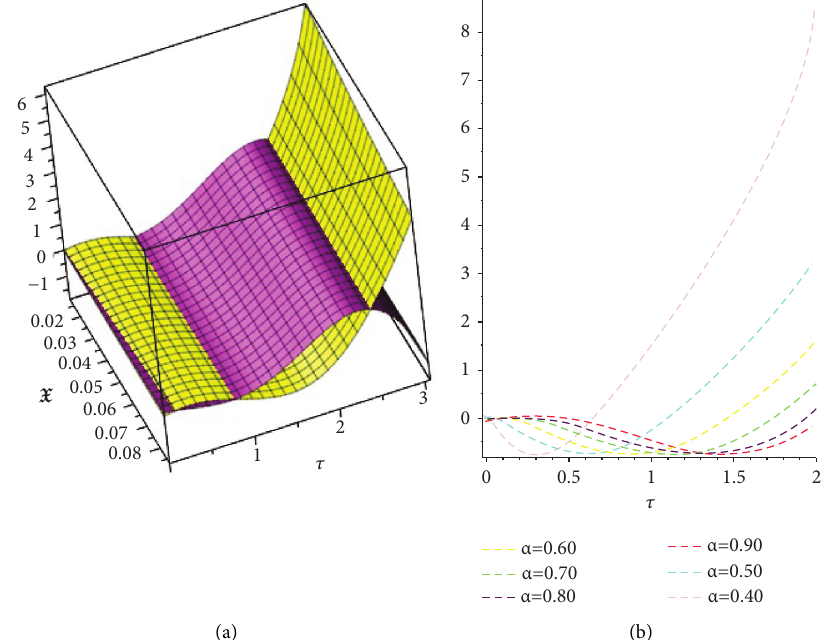
and also 2D with the imaginary part of the solution Ψ for fixed 2 , 1 2 , 1 and also Ψ , represented by Δ and Δ , for different values of X and τ . 1 , 1 2 , 1 TEM MTEM τ � 0.012, 0.037, and